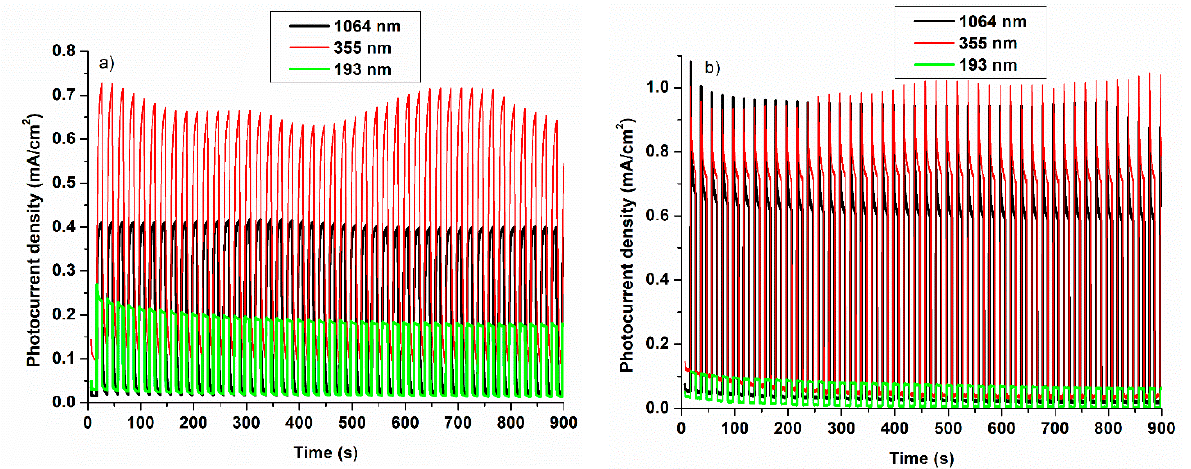
Figure 6. Potentiostatic measurements of WO 3 /PtSi thin films manufactured at different laser wavelengths in ( a ) alkaline electrolyte: NaOH and ( b ) acidic electrolyte: H 2 SO 4 (0.4 V vs. Ag/AgCl).